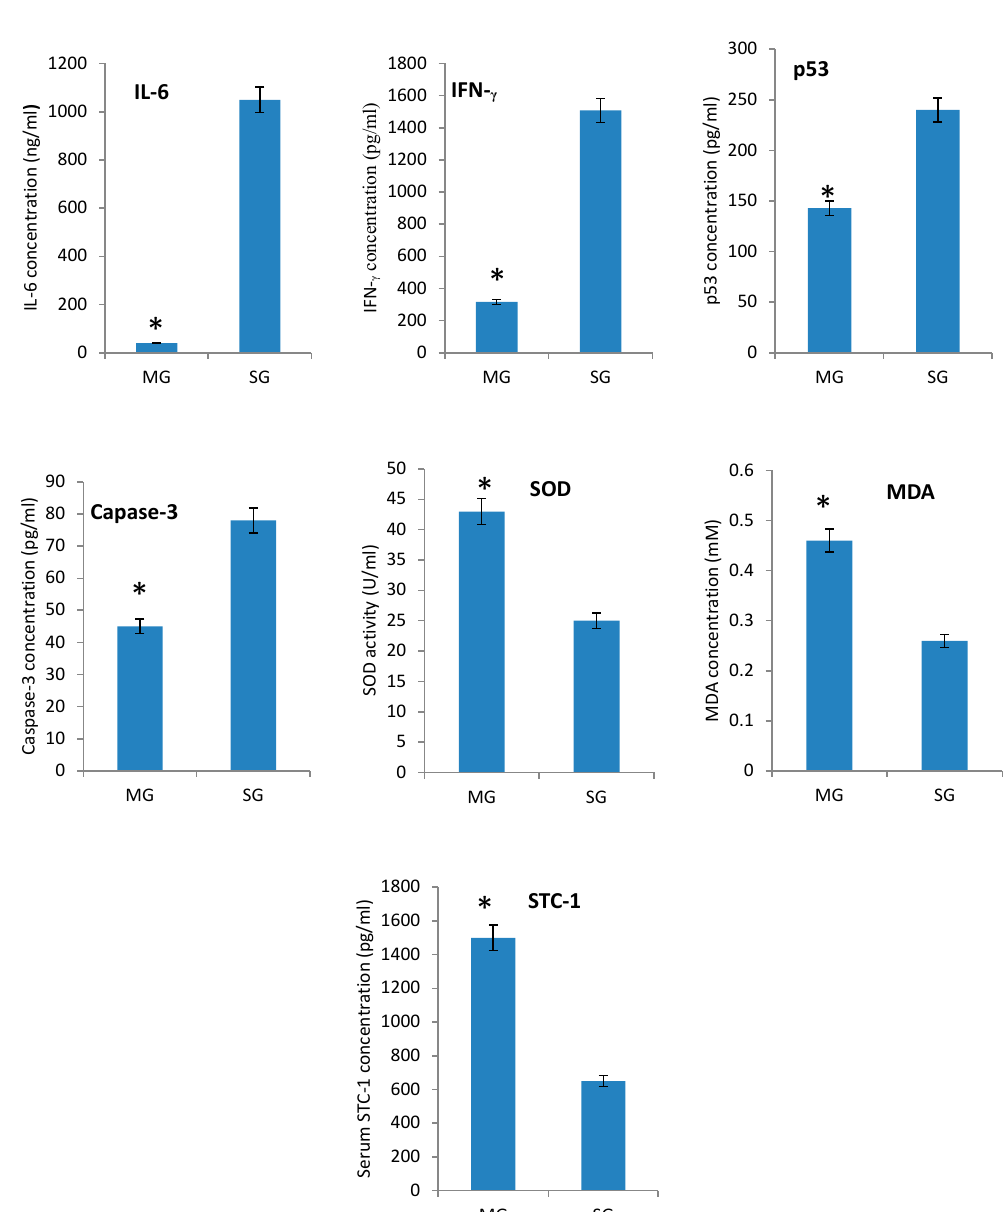
Figure 2. The serum biochemical and immunological parameters in different treated mice: ( A ) the serum protein levels of IL-6; ( B ) the serum protein levels of IFN- γ ; ( C ) the serum protein levels of p53; ( D ) the serum protein levels of caspase-3; ( E ) the serum activity of SOD; ( F ) the serum protein levels of MDA; and ( G ) the serum protein levels of STC-1. Among 16 mice, eight mice were used to create RIRI models and another eight mice were used as a sham group. All data were presented as mean values ± S.D. * p < 0.05 compared to the model group.